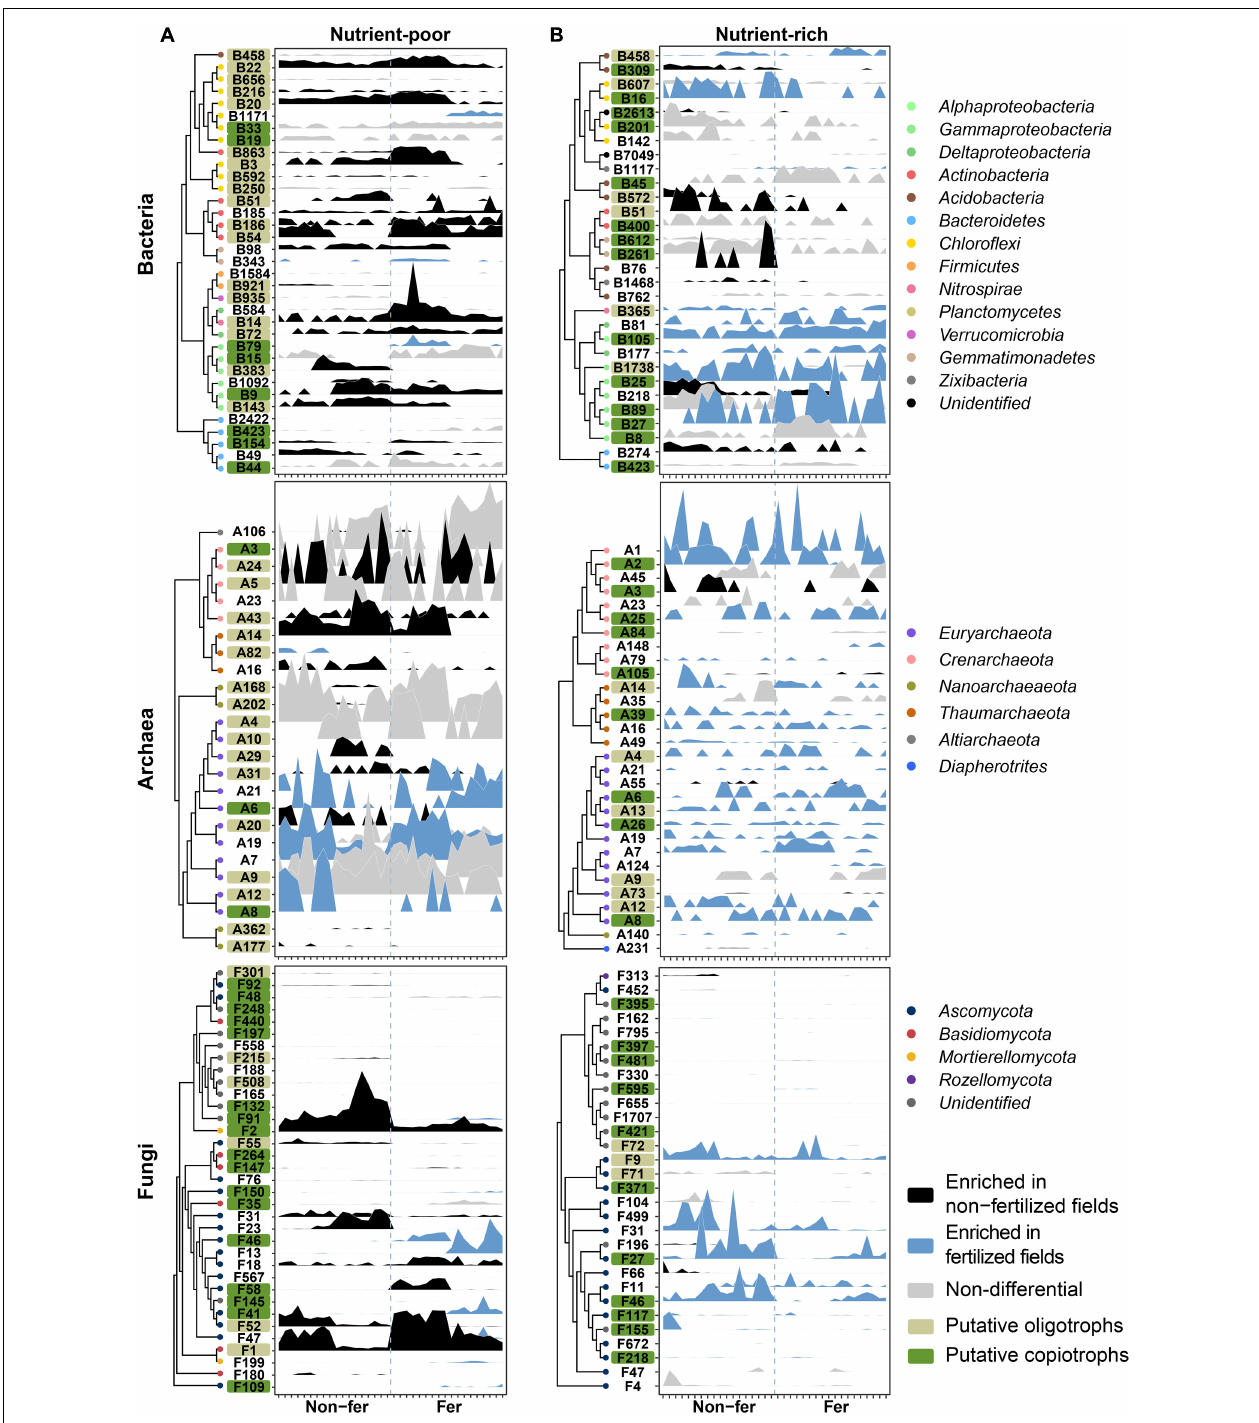
FIGURE 4 | Relative abundance profiles of fertilization-responsive OTUs in nutrient-poor and nutrient-rich environments from random forest classification. OTUs are colored based on their categorization as “non-fertilized field-enriched,” “fertilized field-enriched,” and “non-differential” according to the results of the differential abundance test presented in Supplementary Figure 13 . The RF models for each community in (A) nutrient-poor and (B) nutrient-rich environments were constructed using a 10-fold cross validation method. OTUs were ranked based on their contribution to the accuracy of prediction in the RF model, which was determined by calculating the mean decrease in Gini impurity. OTUs are ordered along the y -axis based on phylogenetic relationships among OTUs. Each tick on the x -axis indicates an individual sample of non-fertilized and fertilized fields. Non-fer, non-fertilized fields; Fer, fertilized fields.